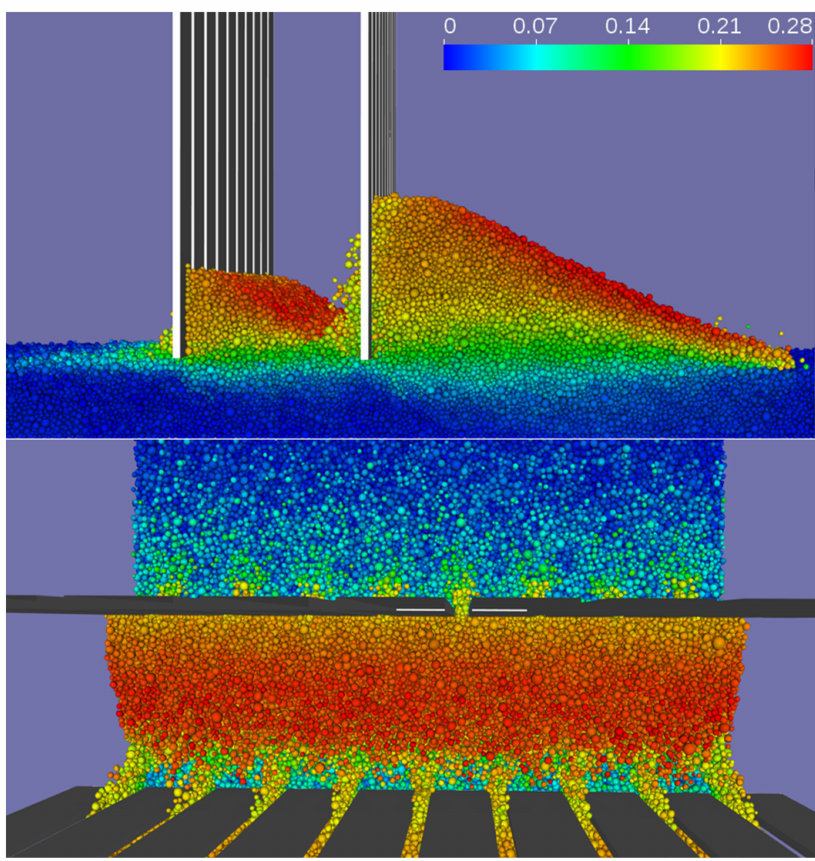
Figure 2. DEM simulation of the powder layer addition with a toothed recoater travelling at 0.23 m/s. Snapshot taken after the powder heap has stabilised. Scale bar colours particle velocity measured in (m/s).